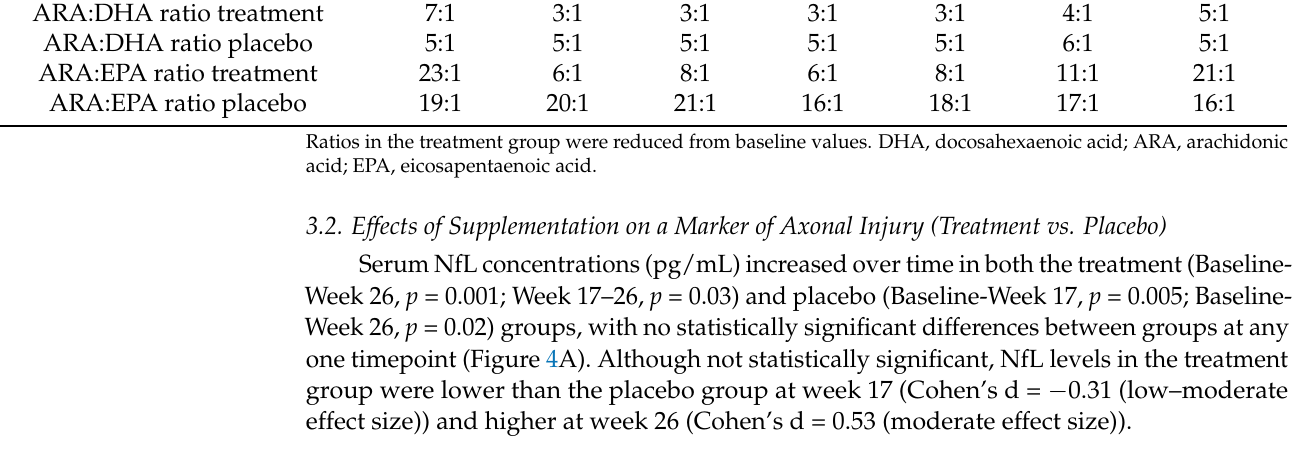
Table 2. ARA:DHA and ARA:EPA ratios by group and time. Baseline Week